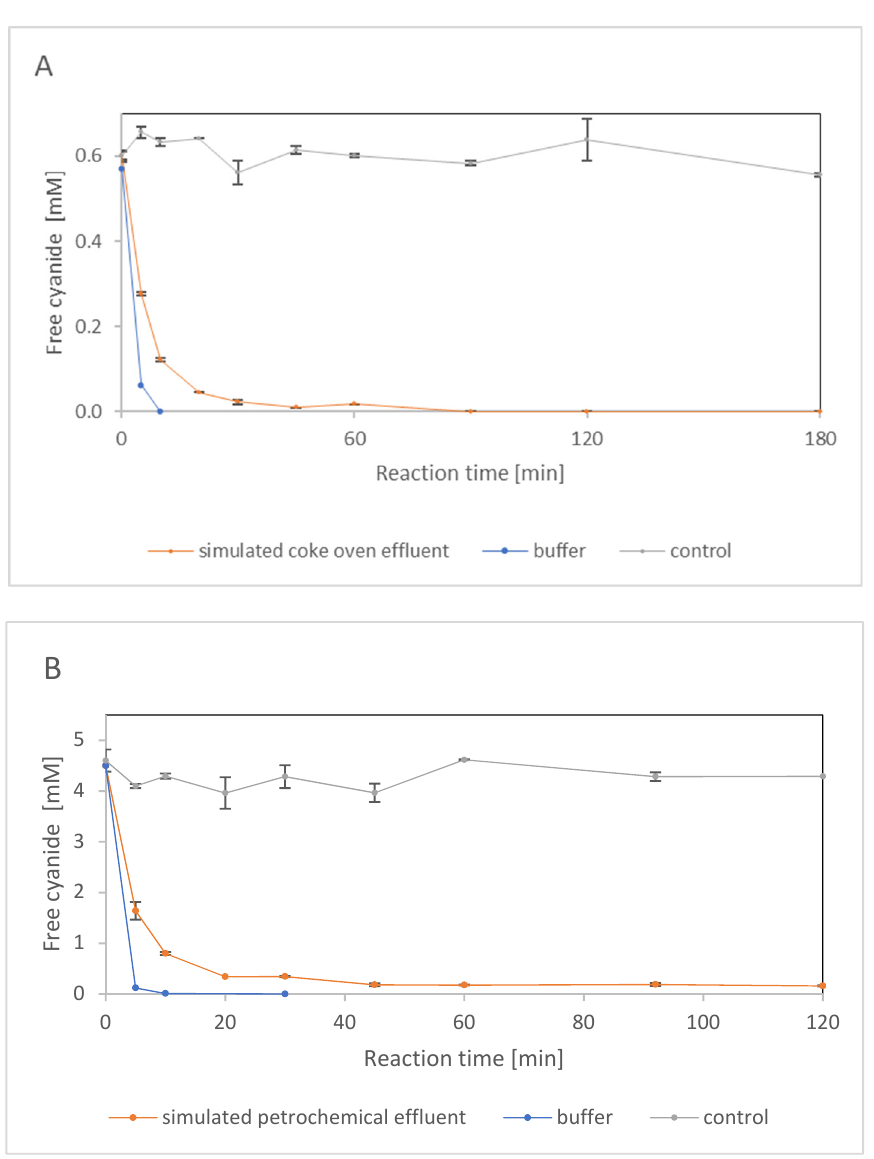
Figure 6. Biocatalyzed degradation of free cyanide (fCN) by enzyme NitEg in 100 mM glycine/NaOH, pH 9.1, containing ( A ) 0.6 mM fCN, 8.6 mM SCN − , 10.7 mM NH 4+ and 12.8 mM phenol (model coke plant effluent) [8], and ( B ) 4.6 mM fCN, 23.4 mM S 2 − , 2.5 mM NH 4 + and 0.64 mM phe- ( A ) 0.6 mM fCN or ( B ) 4.6 mM fCN without other additives. Enzyme concentration was ( A ) 2.5 µ g/mL, and ( B ) 5.0 µ g/mL. The enzyme was omitted from the controls. Residual fCN concentration was determined by ( A ) picric acid method or ( B ) Spectroquant ®